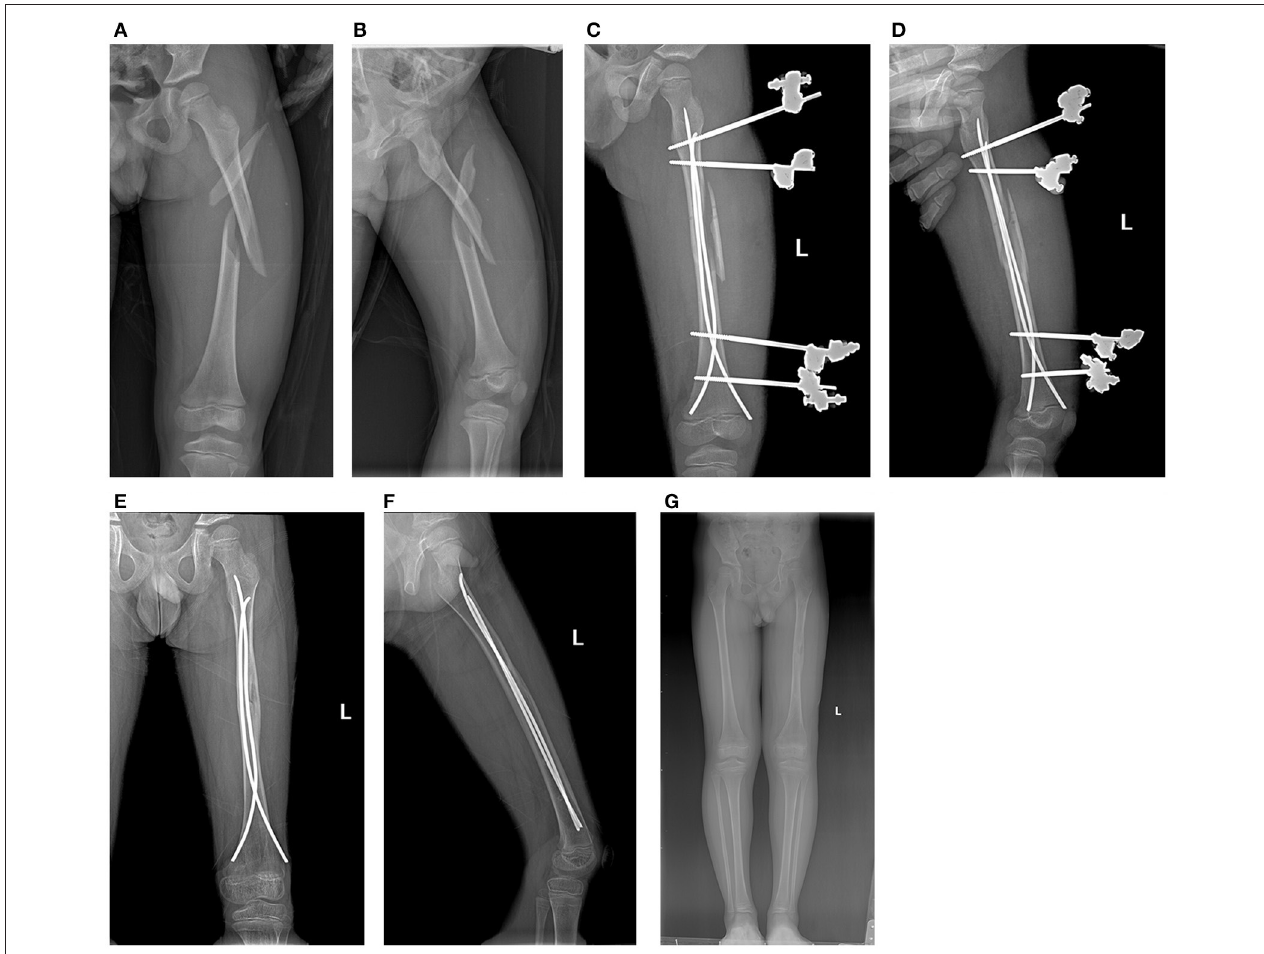
FIGURE 2 | Case 5. (A,B) Comminuted type III femur fracture in an 8-year-old boy; (C,D) postoperative radiographs; (E,F) removal of EF; (G) final